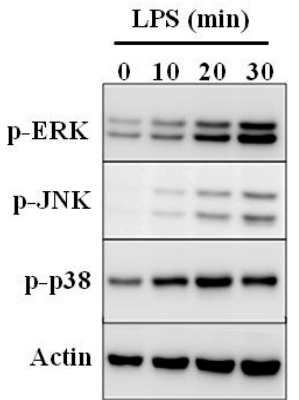
Figure 5. Mechanism of endotoxin tolerance induced by CGL. RAW264.7 macrophages treated with or without CGL (10 µg/mL) for 24 h were subsequently incubated for 0–30 min with or without LPS (1 µg/mL). Figure was modified from [49].